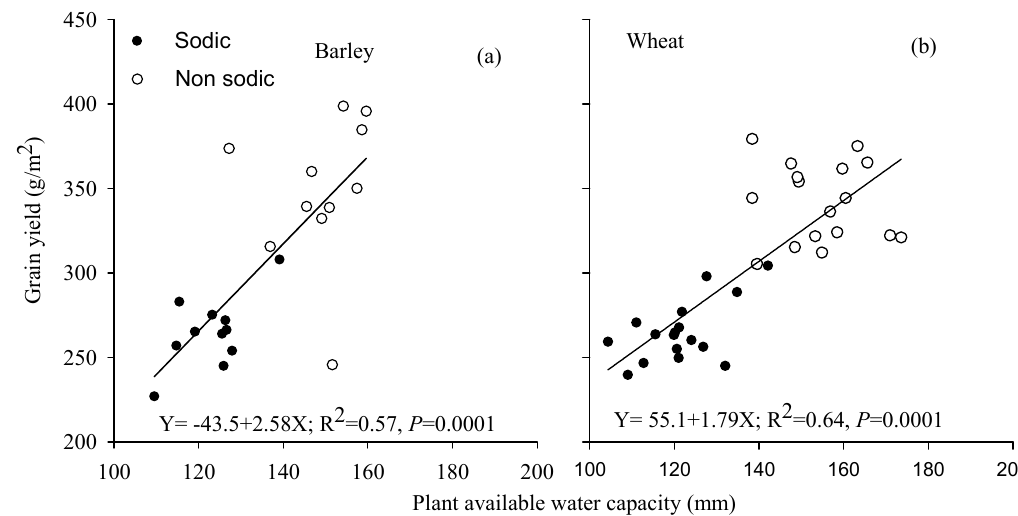
Figure 4. Relationships between grain yield of ( a ) wheat and ( b ) barley genotypes with plant available water capacity of wheat and barley genotypes, respectively, grown on a sodic site and a non-sodic site at Goondiwindi in southern Queensland in 2008.